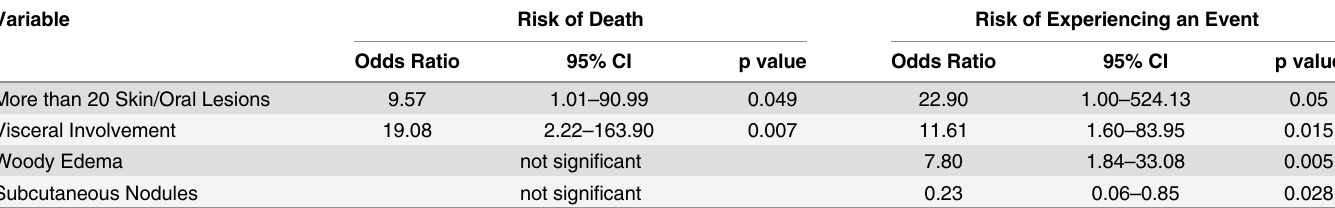
Table 3. Multivariate Analysis of Variables Associated with Risk of Death and of Experiencing an